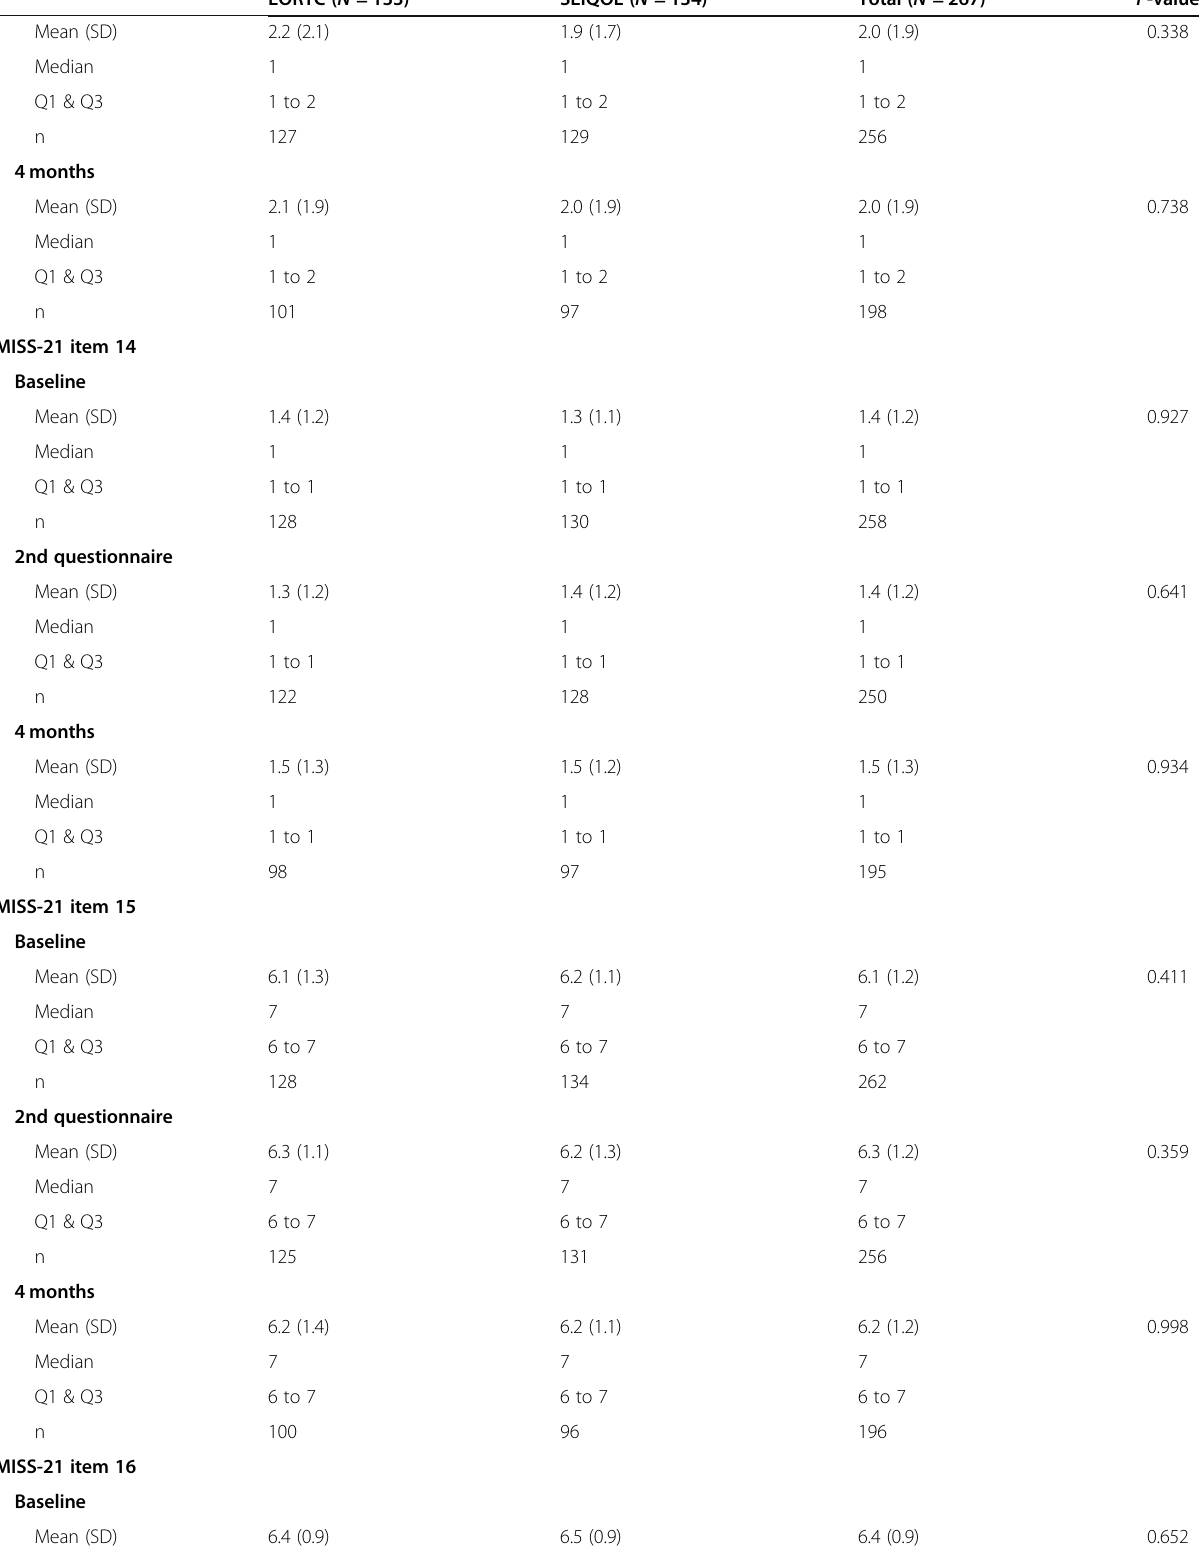
Table 2 Outcomes a over time for analyzed patients